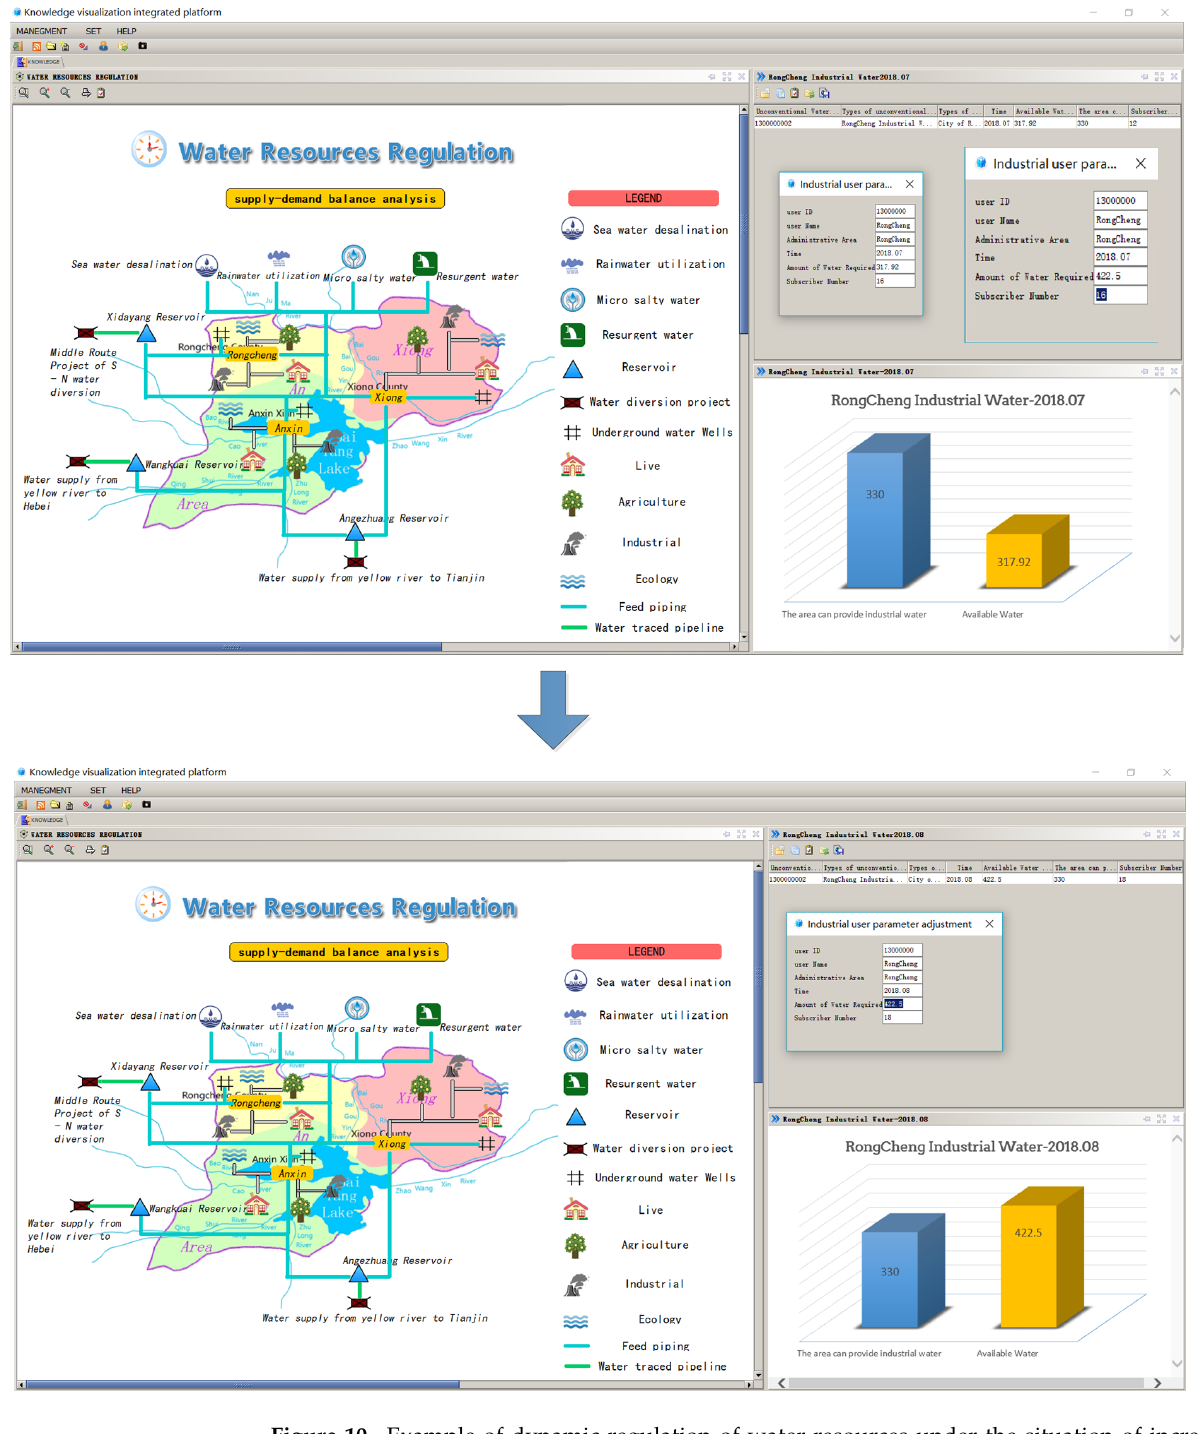
Figure 10. Example of dynamic regulation of water resources under the situation of increasing water demand.